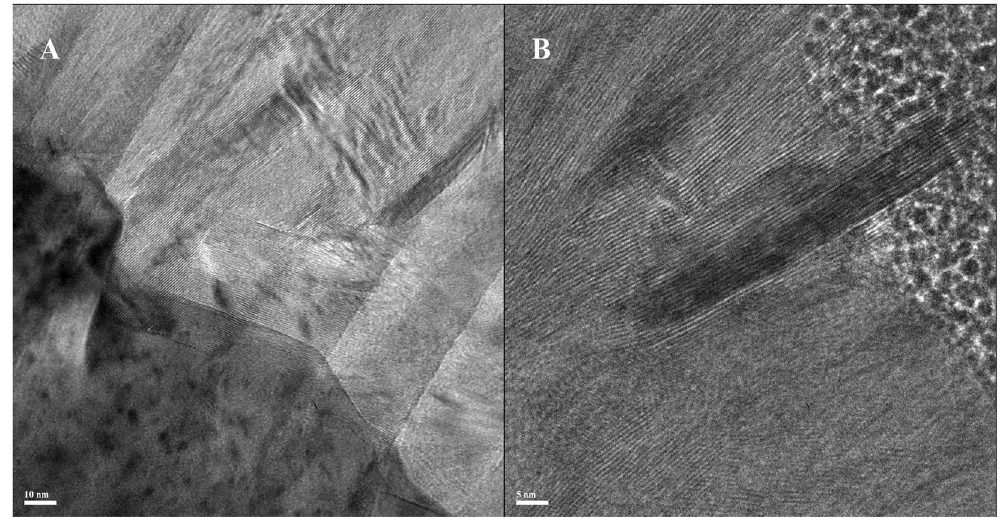
Figure 3. HRTEM of the bottom of the VA-MoS 2 #1 at the interface with Mo ( A ) and HRTEM of the top of the film ( B